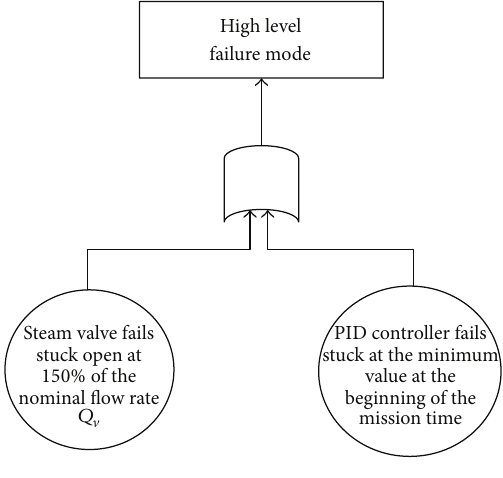
Figure 16: Fault tree for the high level failure mode. Table 5: Possible system configurations to be considered in the static reliability analysis with constant power